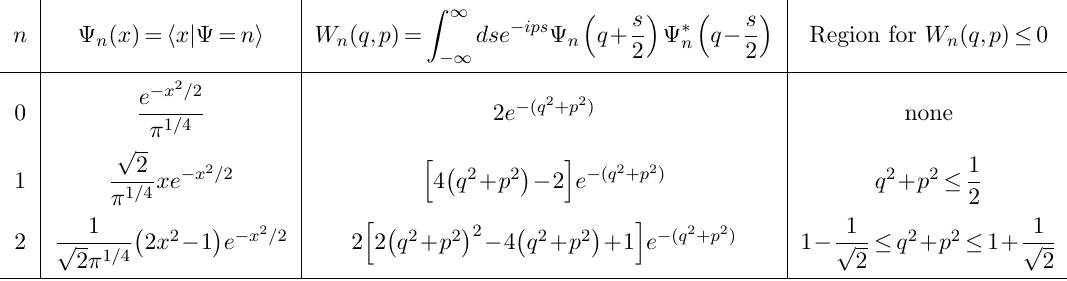
Table 1 . The Wigner functions W n ( q;p ) of a quantum harmonic oscillator and the region where W n (cid:20) 0 for the states n = 0, 1 and